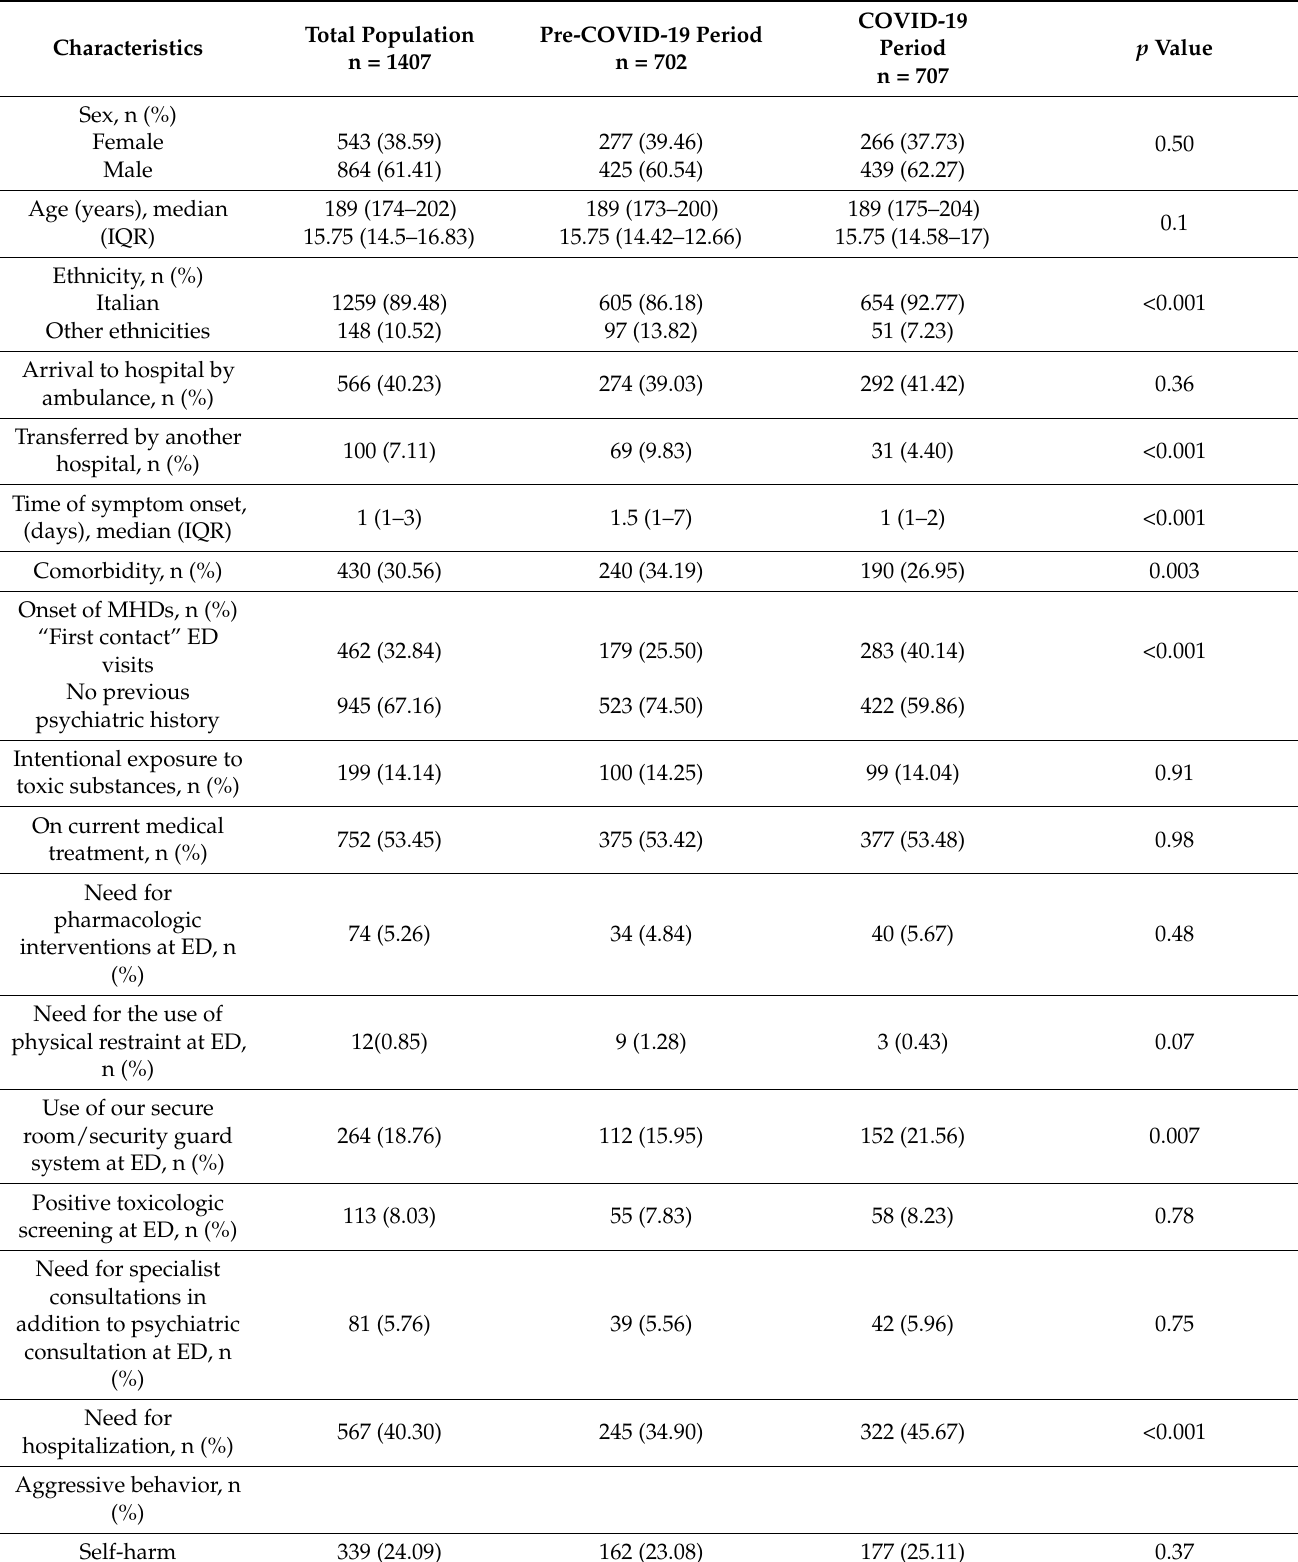
Table 2. Characteristics of mental health emergency visits among adolescents before and during the COVID-19